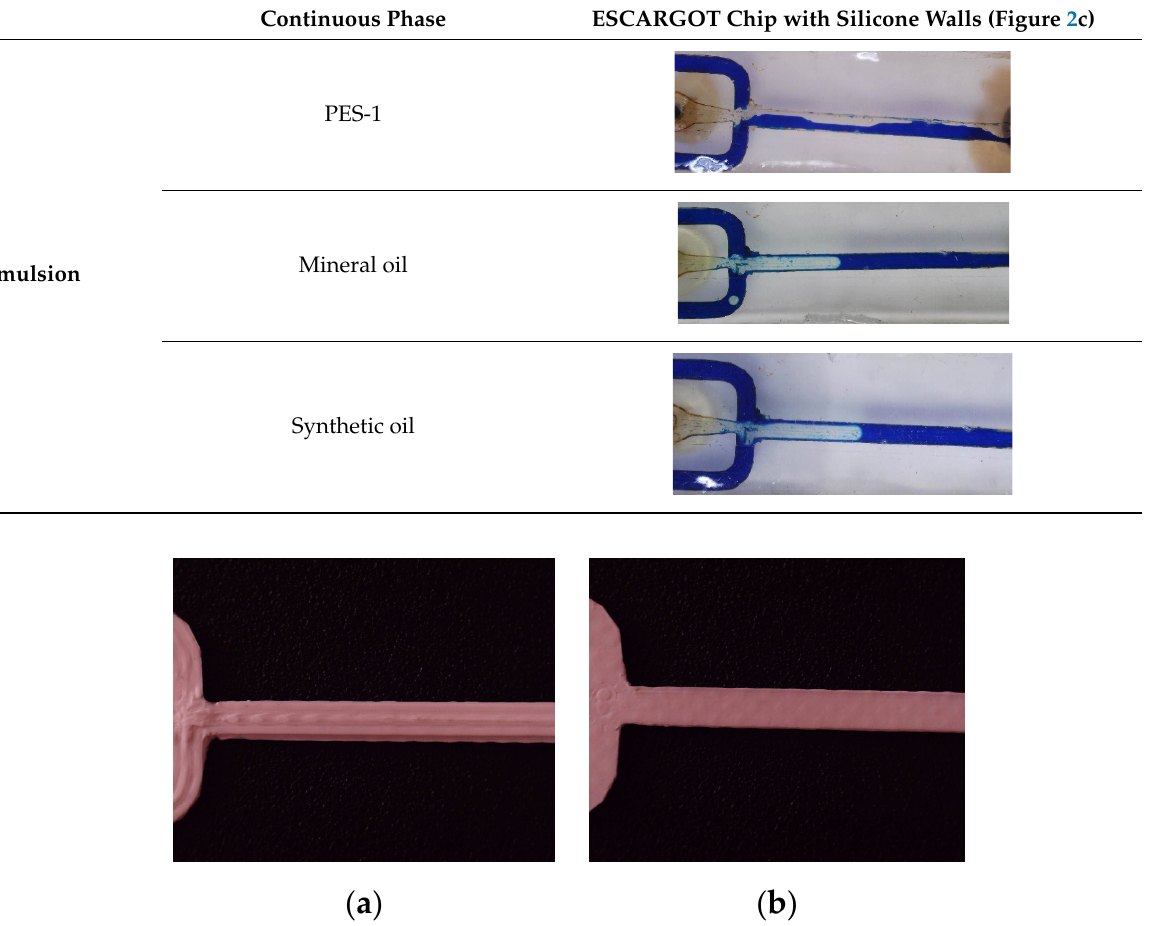
Figure 3. The surface of the scaffolds for ESCARGOT chip with silicone walls (Figure 2c): ( a ) the original surface of the scaffold with traces of 3D printing; ( b ) the surface treated in acetone vapor.